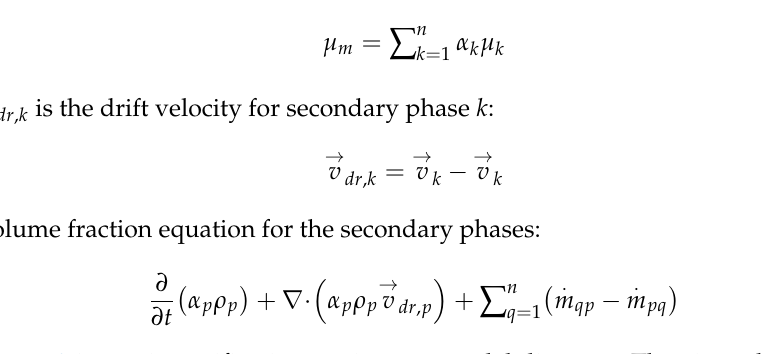
Figure 3. Air purifier filter setting diagram. Figure 4 is a schematic diagram of the consultation room (Case 1). The distance be- tween the human body’s exhalation port and the floor is from point A to point C, with a 1.0 m set value. The interpersonal distance is 1.4 m from point A to point B, with the ex- halation port as the center. The human body’s exhalation port airflow direction at point A is from point A to point B. The human body’s exhalation port airflow direction at point B is from point B to point A. The air purifier airflow outlet is shown at point D. The air inlet position is as shown at point E. This is a closed space.